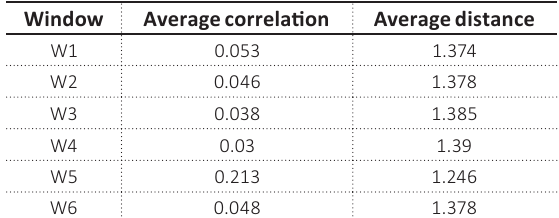
Table 3. Dynamic variation of the mean correlation and distances